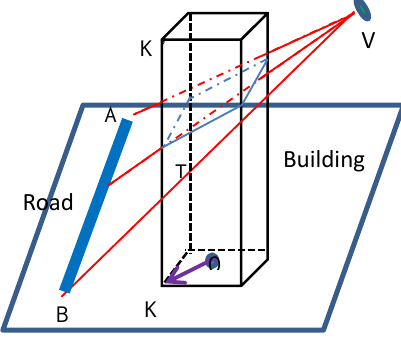
Figure 5. Visibility measurement for the line segment AB .